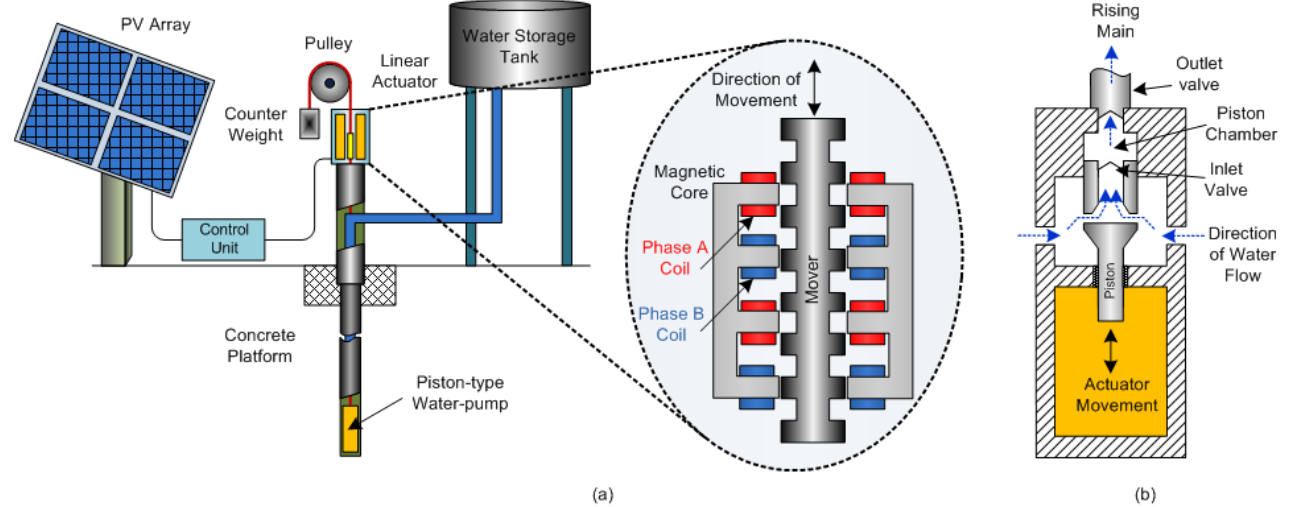
Figure 11. Linear water pump actuators ( a ) variable-reluctance linear stepper motor; ( b ) linear pump